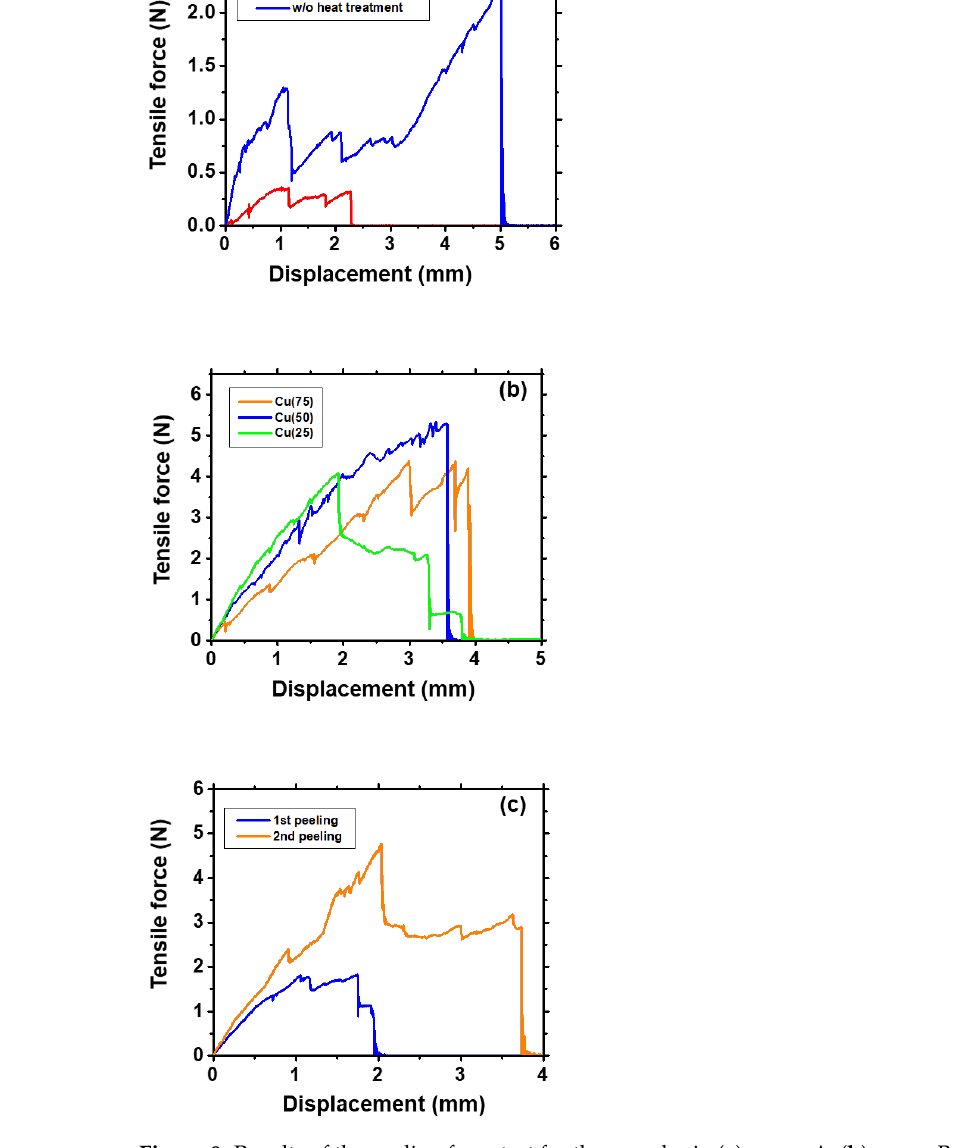
Figure 9. Results of the peeling force test for the samples in ( a ) group A, ( b ) group B, and ( c ) group C. Table 4. Peeling properties of the samples in each group.